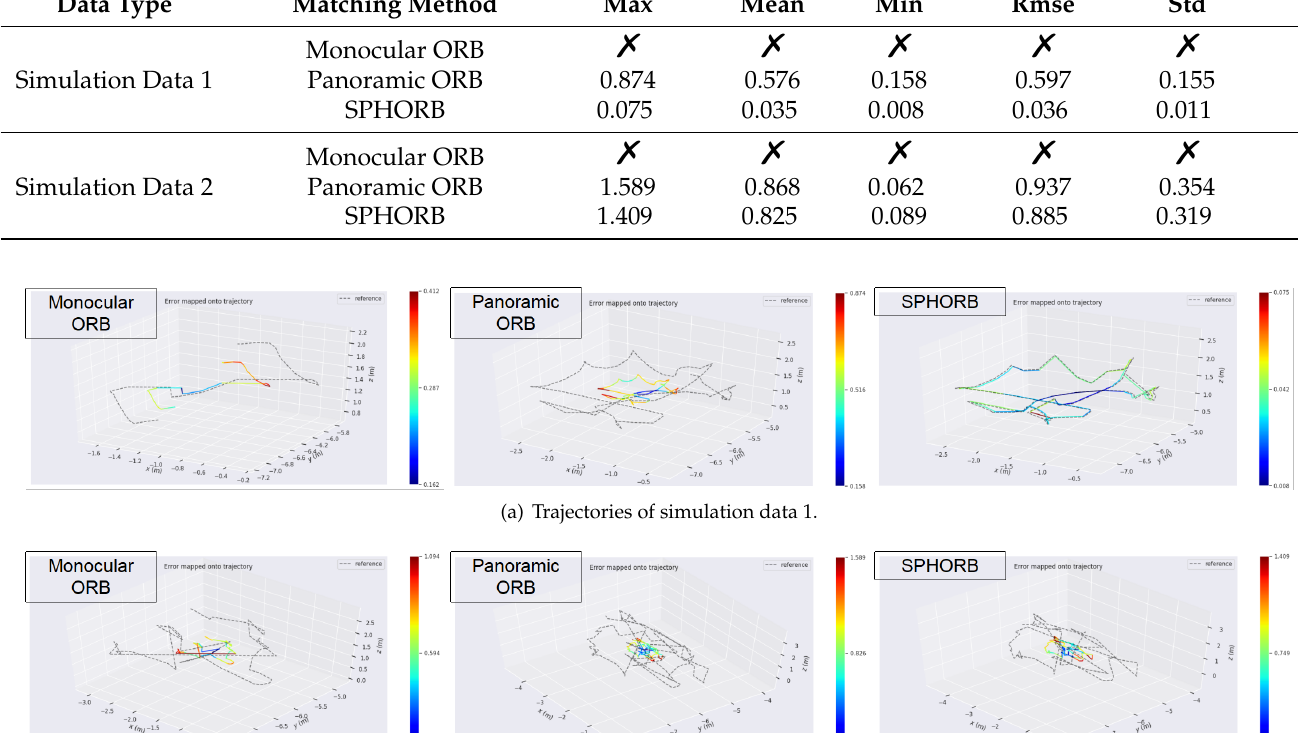
Table 5. EVO evaluation of monocular ORB, panoramic ORB and SPHORB. ( (cid:37) ) means there exist tracking failures. Data Type